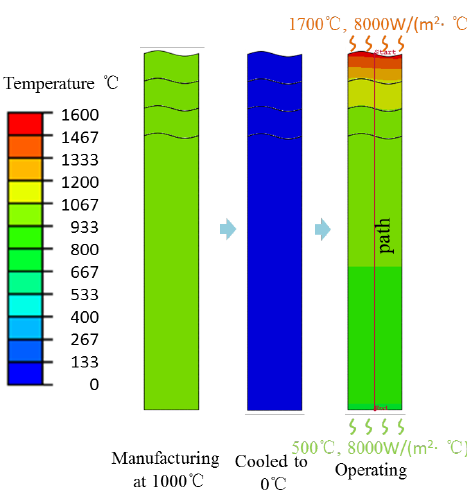
Figure 3. Temperature field of during the simulation process for CMCs coatings.